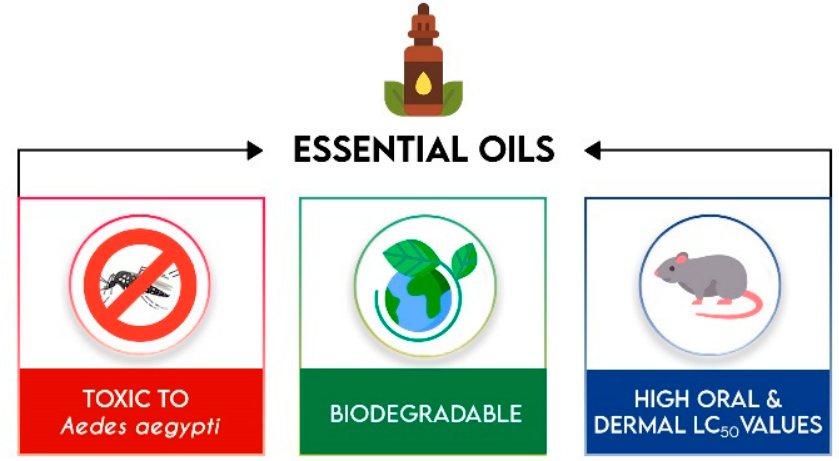
Figure 2. Essential oils to combat the Ae. aegypti mosquito: an ecologically safe